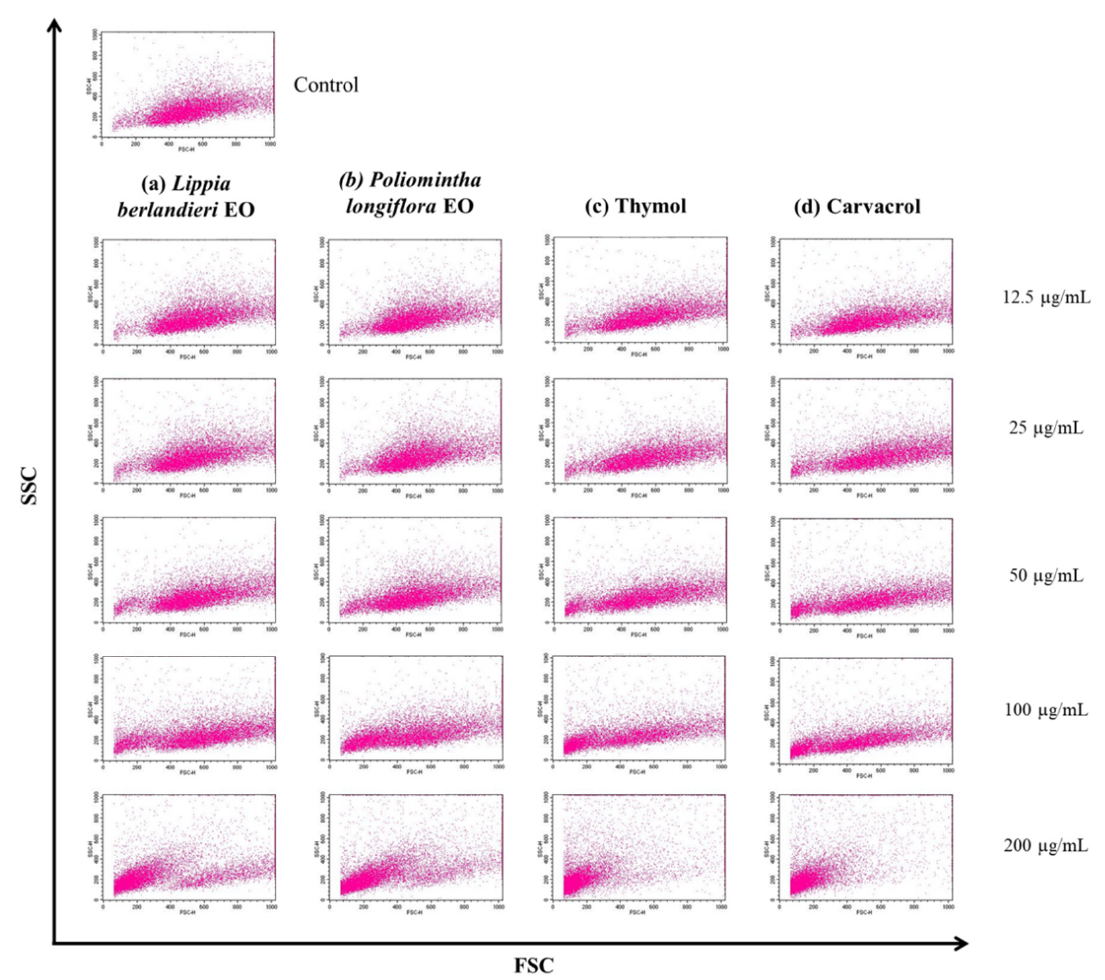
Figure 3. Effect of ( a ) Lippia berlandieri EO, ( b ) Poliomintha longiflora EO, ( c ) thymol, and ( d ) carvacrol on size (FSC) and granularity (SSC) of Leishmania (L.) mexicana promastigotes. Parasites were treated with 0, 12.5, 25, 50, 100, and 200 µg/mL of EOs or pure compounds, incubated for 24h, and analyzed by flow cytometry. Images are representative of three independent experiments.